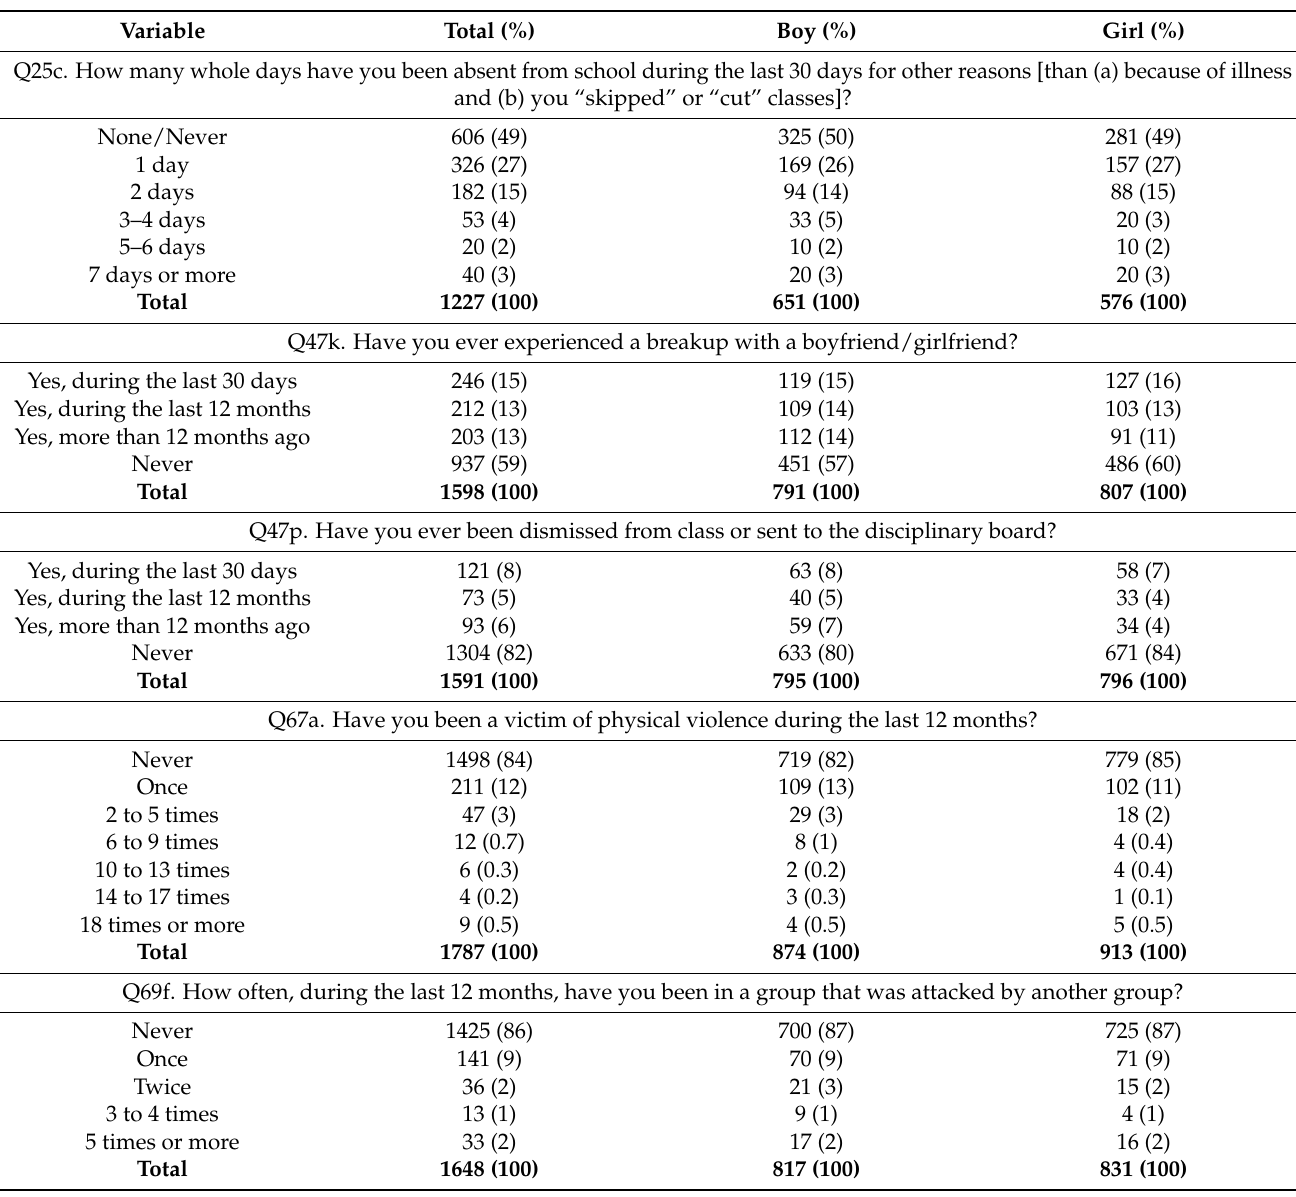
Table 2. Frequency table of selected behavioural and experienced variables, by gender.